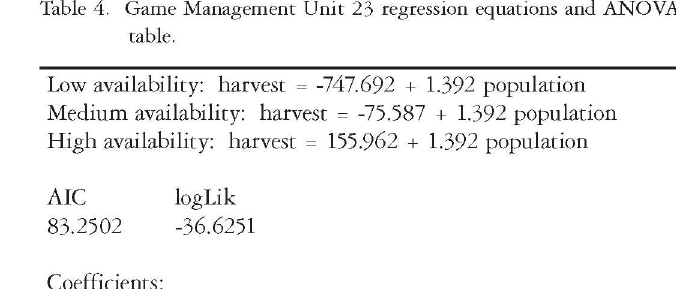
Table 4. Game Management Unit 23 regression equations and ANOVA table.